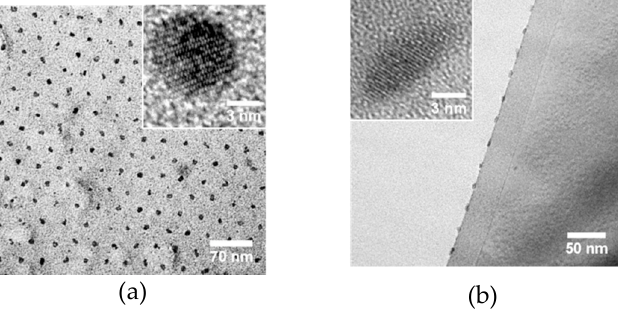
Figure 5. ( a ) Plane view and ( b ) cross-sectional transmission electron microscopy (TEM) images of the CFO nanodots obtained from SEO-49k template. The insets are the high-magnification images.